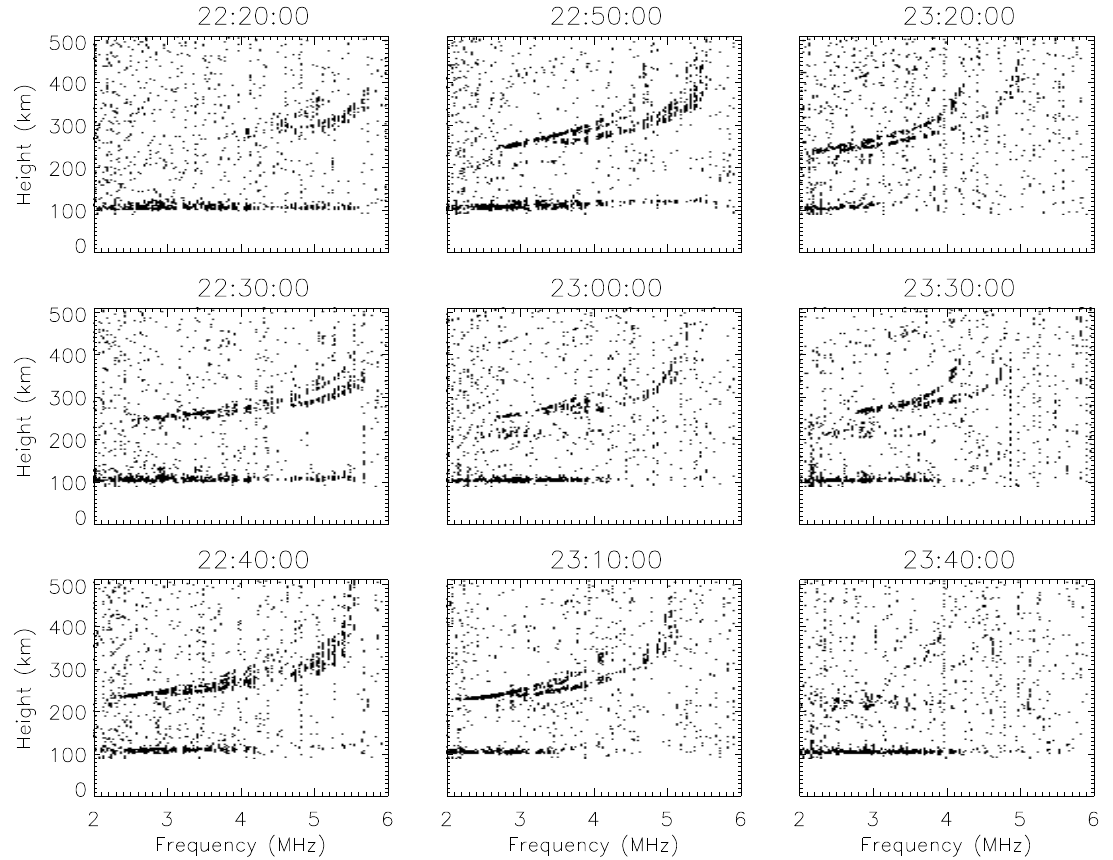
Fig. 2. Ionograms from the period 22:20 to 23:40 UT on 11 July 1995. During this period sporadic- E is clearly